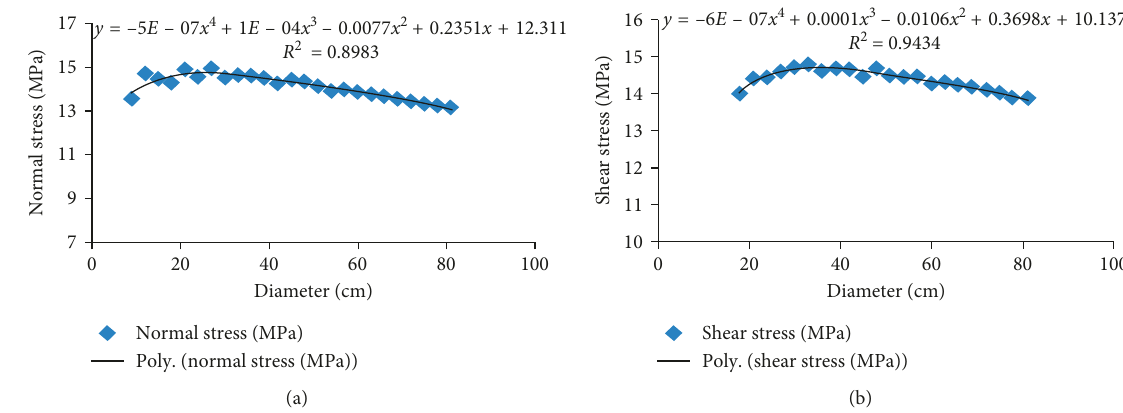
Figure 6: (a) Normal stress versus diameter of the hole. (b) Tangential stress versus diameter of the hole.